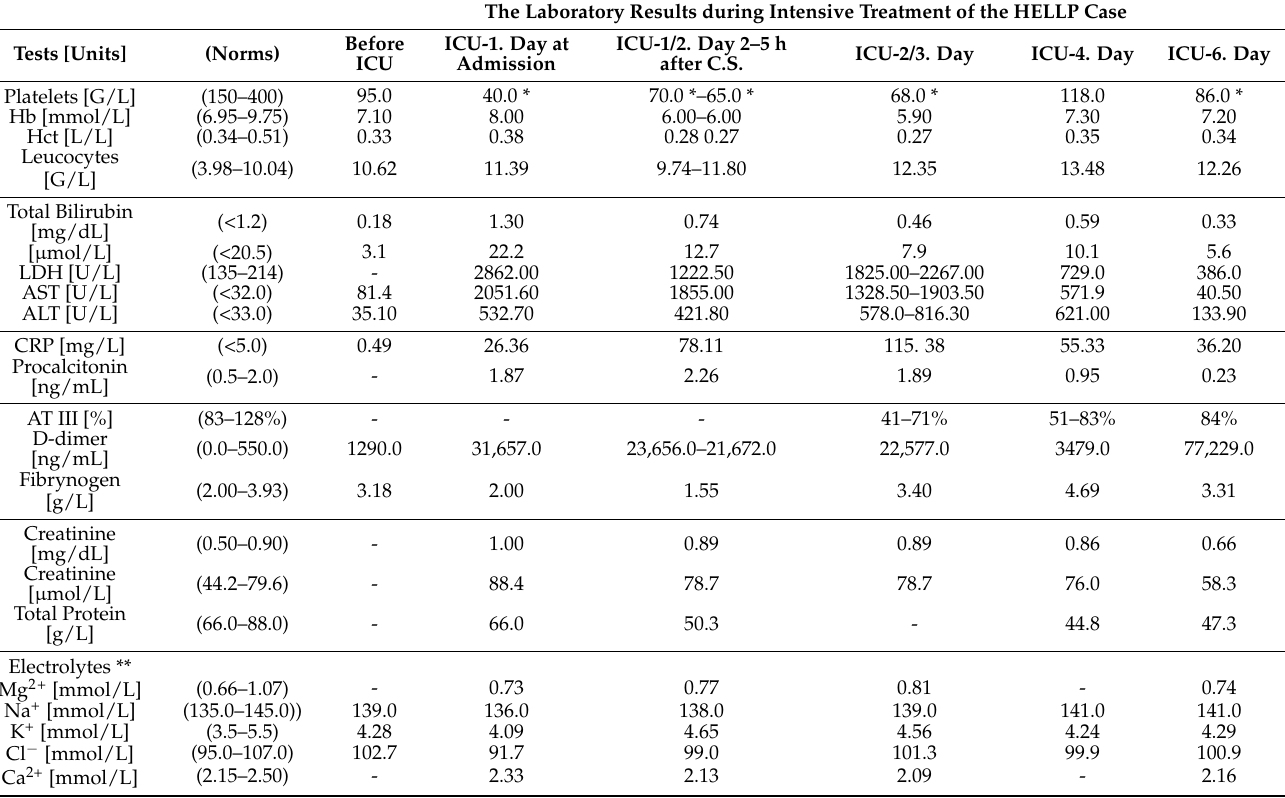
Table 1. The laboratory results during intensive treatment of the HELLP